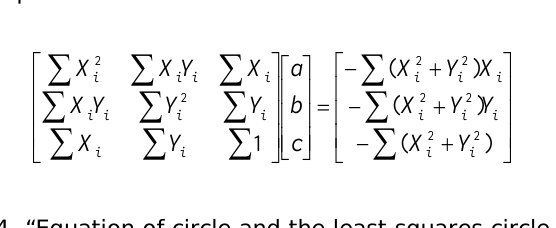
Equation 4. “Equation of circle and the least squares circle